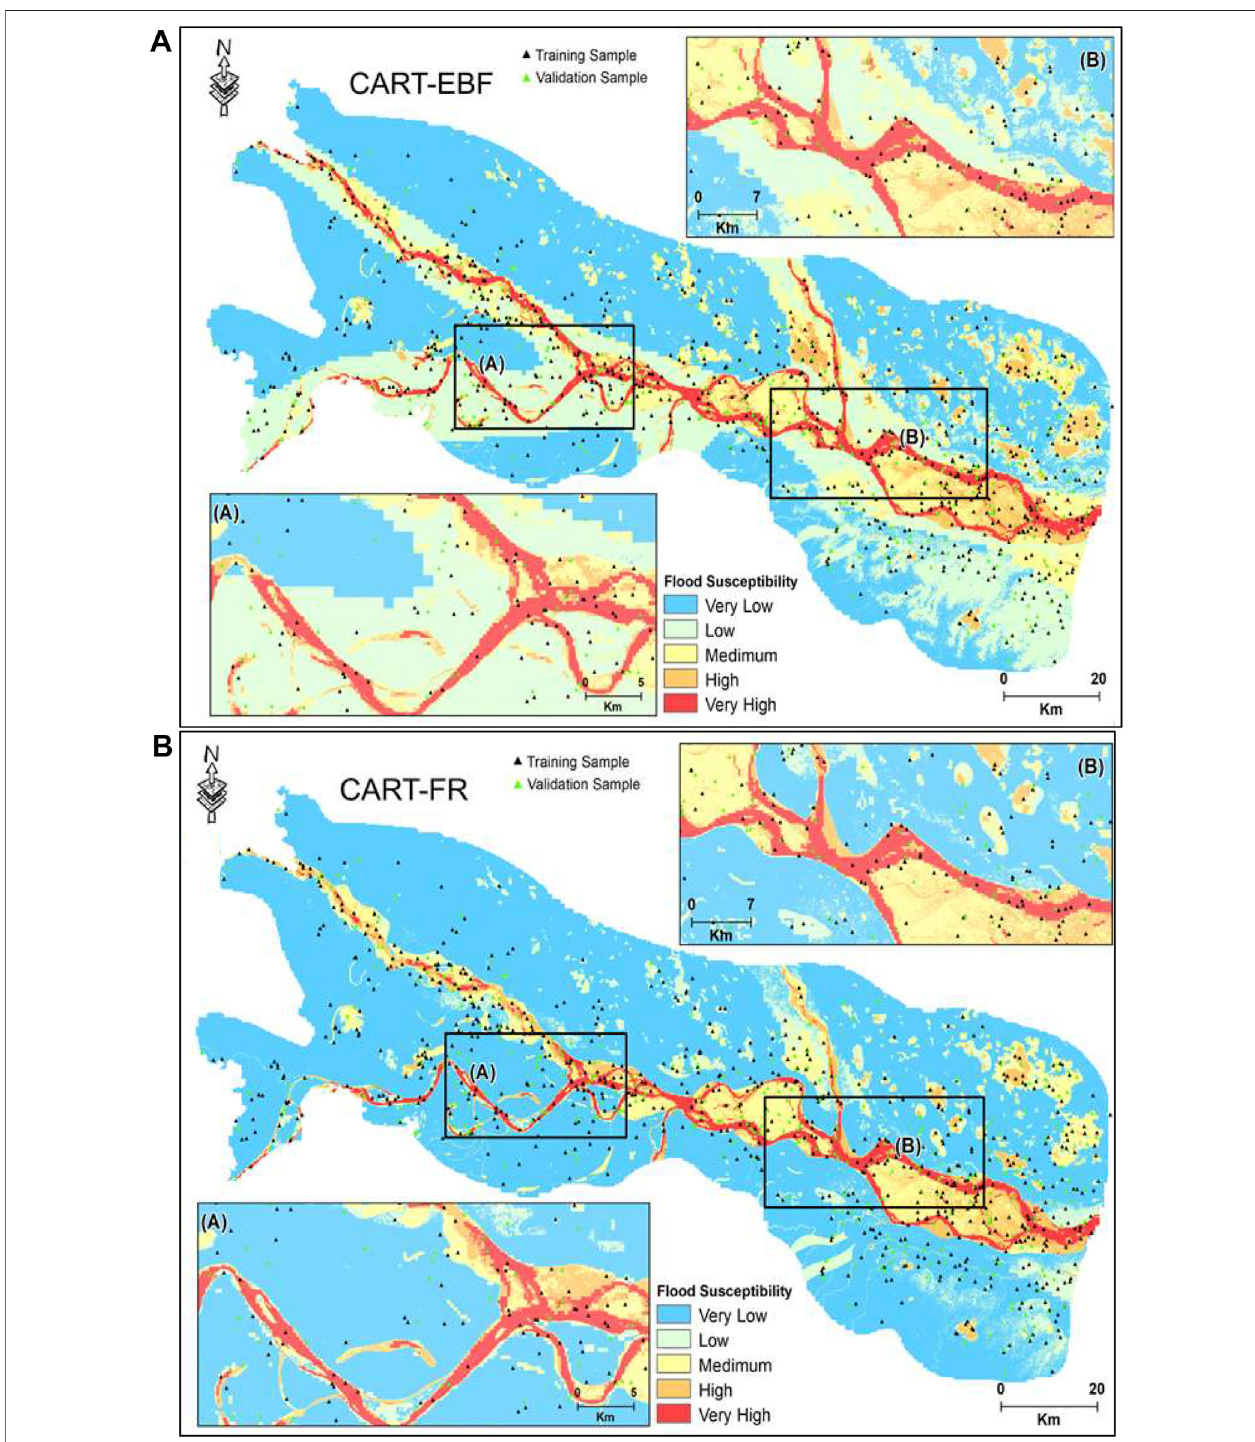
FIGURE5| Floodsusceptibilitymapusingsixensemblemodelscomputedusingmethodsdiscussedin Section5.1 ; (A,B) showFSPIclassi fi edresultsaccording to CART-EBF and CART-FR results. Boxed areas A and B are zoomed windows in each of the model output maps to show detailed FSPI conditions nearby con fl uence zones.